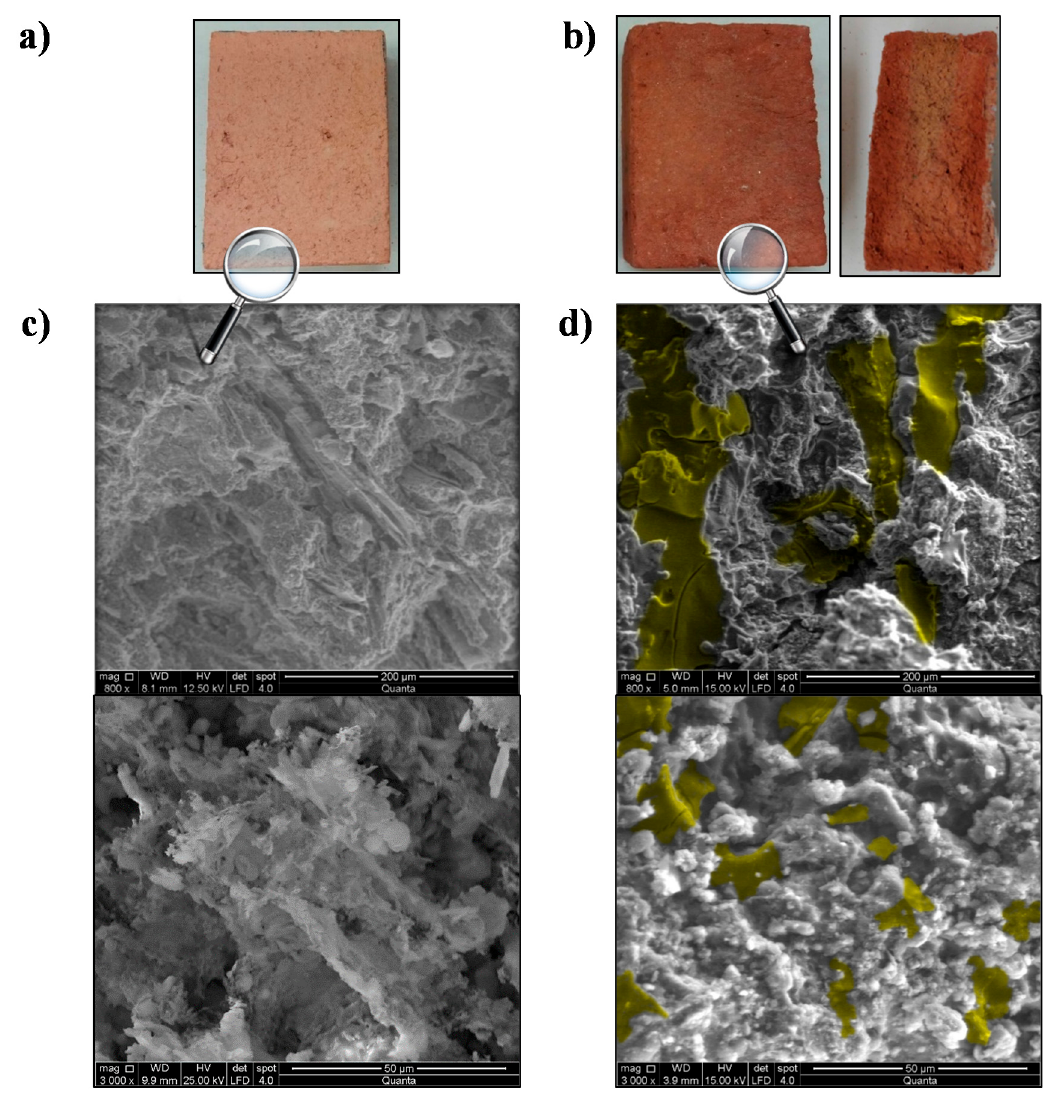
Figure 5. Visual appearance and scanning electron microscopy (SEM) images of D brick inner structure before ( a , c ) and after ( b , d ) the immersion process at different magnifications.